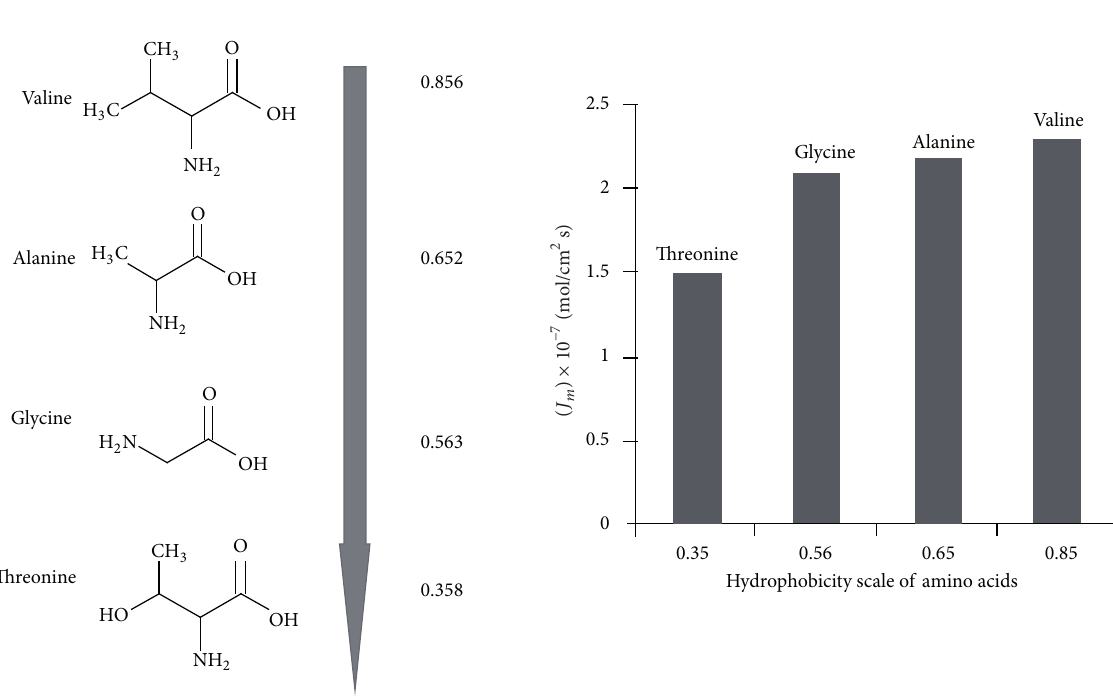
F 8: Hydrophobicity scale and �ux values for amino